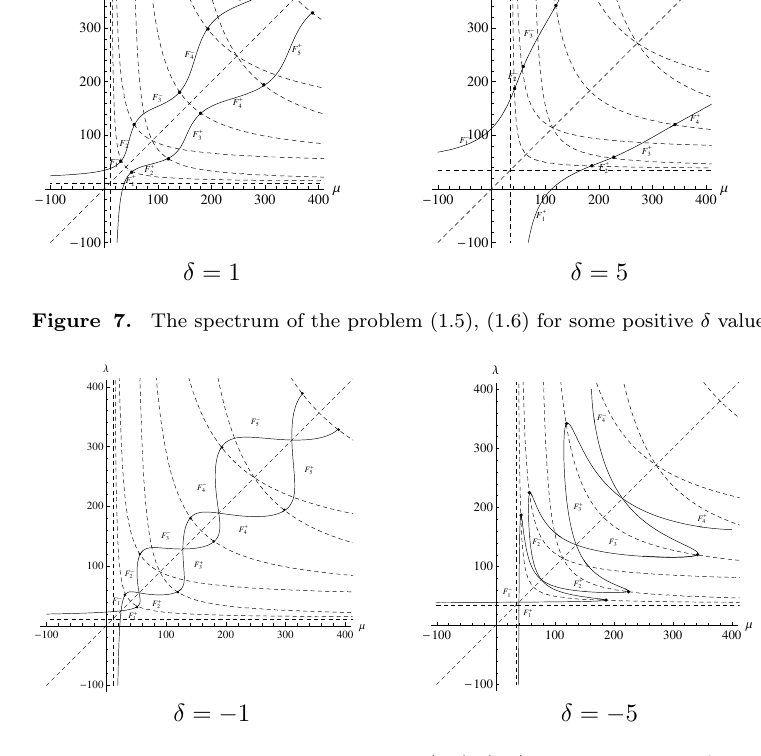
So, consider the problem (1.7),